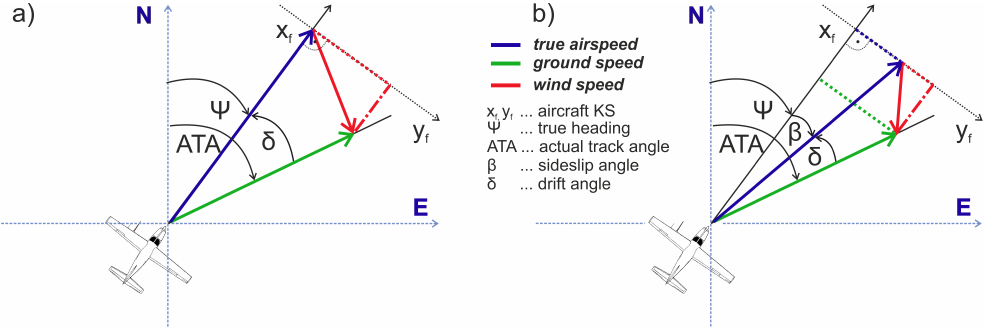
Figure 1. (a) Formation of the wind triangle (two-dimensional) which is used to calculate the wind from an aircraft. (b) Expanded wind triangle; the figure includes the sideslip angle β . This angle is nonzero when for example the aircraft is not flying straight ahead relative to the aircraft coordinate system, the reference system is not well aligned or turbulent wind fluctuations are